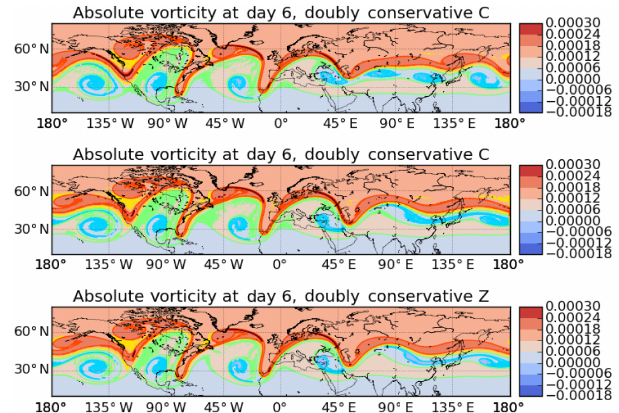
Figure 6. A plot of the absolute vorticity from the Galewsky et al. (2011) test case at day 6 for the C-grid scheme on a cubed-sphere grid (top panel), C- grid scheme an icosahedral grid (middle panel), and Z grid scheme on an icosahedral grid (bottom panel). The de- veloped region of the jet is very similar for all three schemes, and is quite similar to other results in the literature. Some differences can be seen in the undeveloped region of the